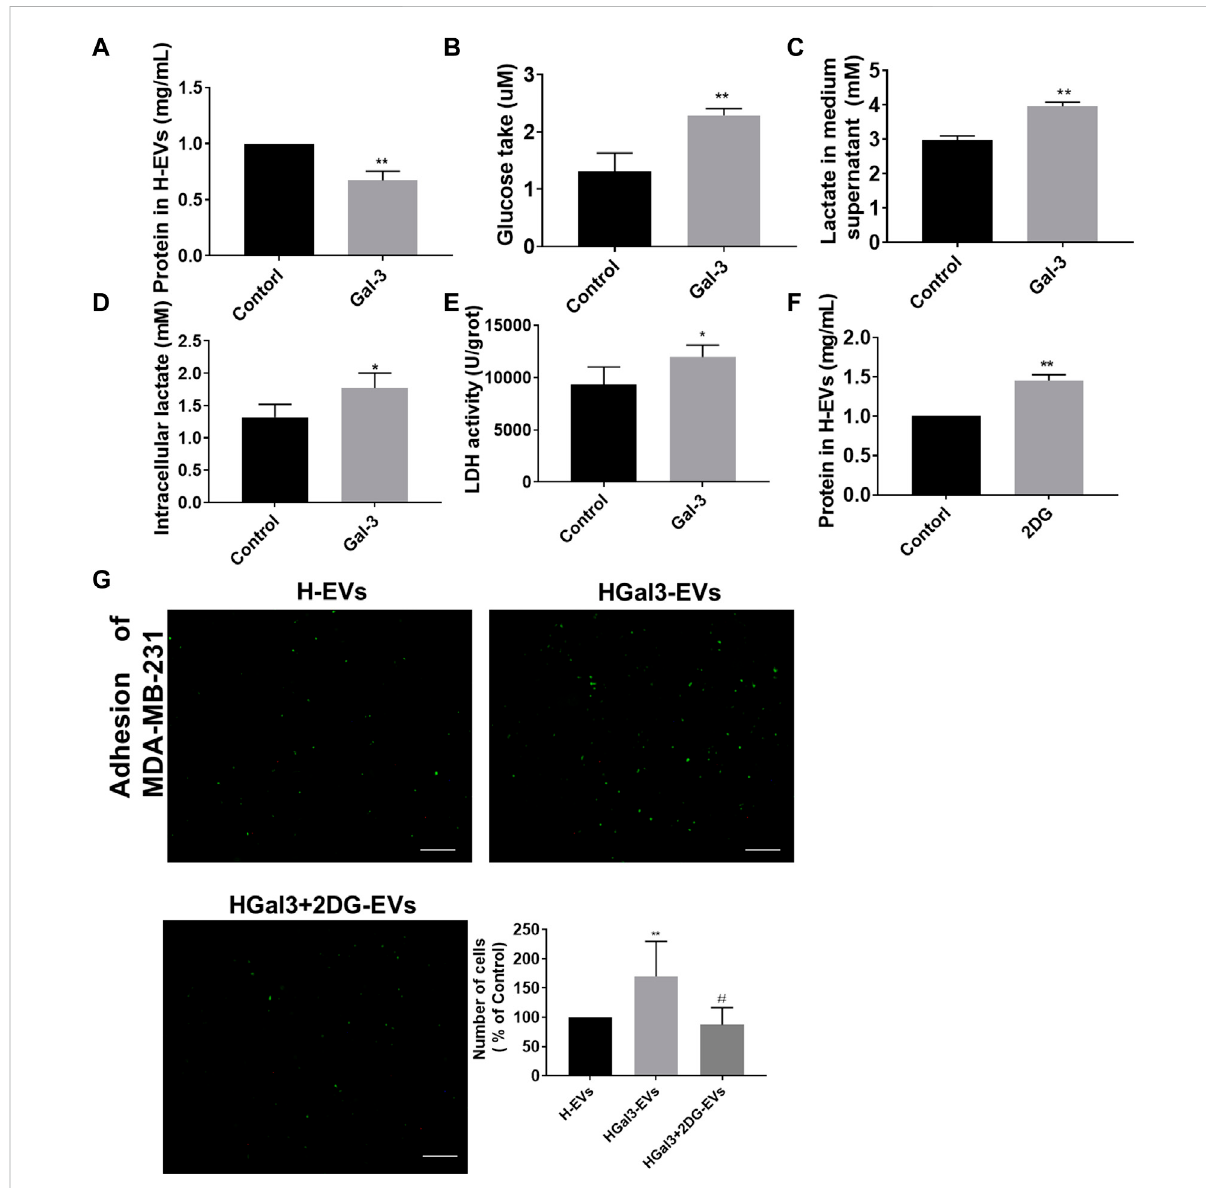
FIGURE 3 Gal-3 increased the glycolysis of HUVECs to promote the effect of H-EVs on cell adhesion. (A) Effect of 1 ng/ml Gal-3 on the protein concentration in H-EVs for 24 h was detected by BCA protein kit. (B) Effect of Gal-3 on the glucose uptake of HUVECs was detected by glucose detection kit. (C,D) Effect of Gal-3 on the intracellular lactate content and lactate secretion of HUVECs were detected by lactate detection kit. (E) Effect of Gal-3 on LDH activity inHUVECswas detected by LDHkit. (F) Effect of 4 nM 2-DG on theprotein concentration inH-EVs for 24 h was detected by BCA protein kit. (G) The effect of HGal3-EVs on the adhesion of MDA-MB-231 cells to HUVECs was detected by adhesion assay (magni fi cation, ×100, bar = 100 μ m). Data are presented as the means ± S.E.M. * p < 0.05, ** p < 0.01, v.s . control group; # p < 0.01, v.s . HGal3-EVs